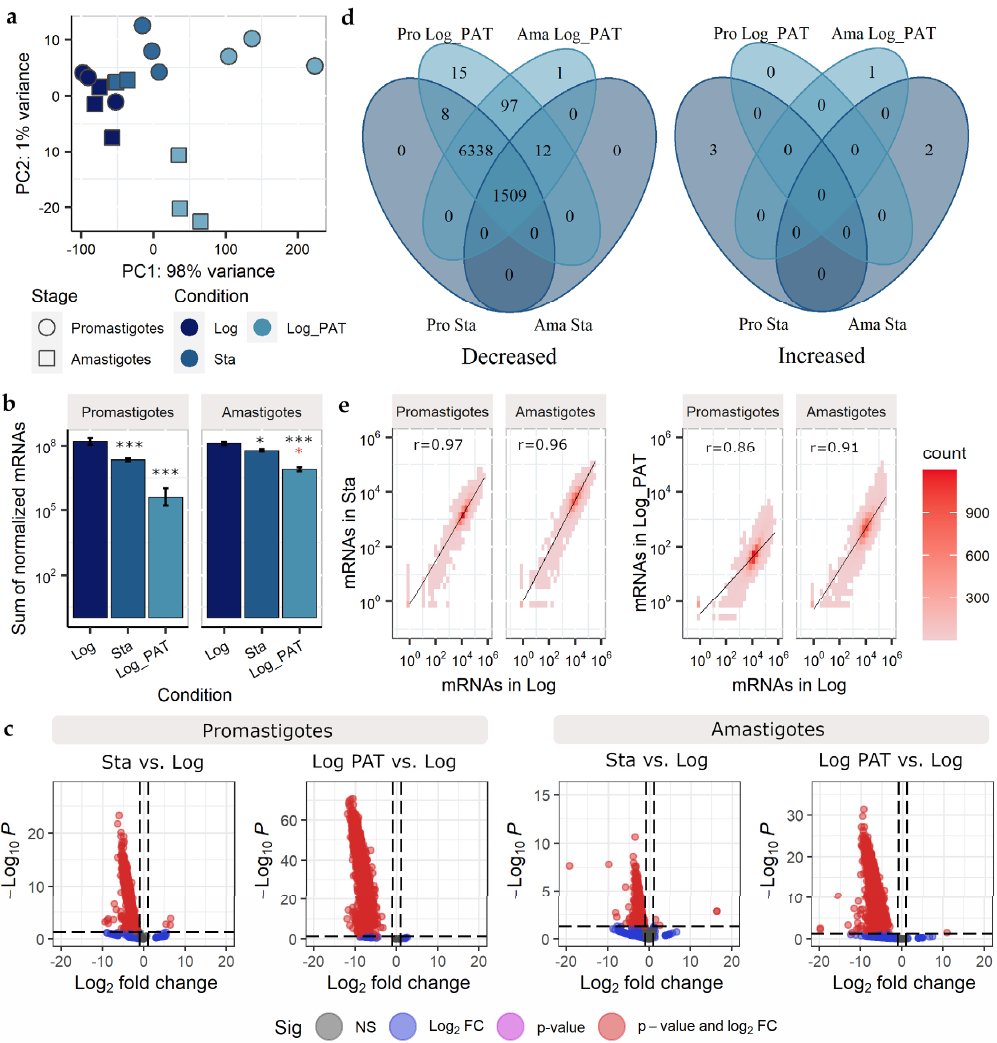
Figure 2. mRNA transcriptome size and global down-shift during quiescence. ( a ) Principal compo- nent analysis showing that most of the variability in the abundance of the mRNAs can be explained by the proliferative condition of Leishmania with quiescent cells induced by PAT drug pressure being the most dissimilar compared to proliferative cells in both promastigotes and amastigotes. ( b ) Sum of normalized mRNAs in each condition and stage of Leishmania showing the diminished transcriptome size in quiescent cells compared to proliferative cells. The bars represent the mean ± SE of three biological replicates. The asterisks in black color represent statistically significant differences after Tukey’s post-hoc test; * indicates p < 0.05, indicates *** p < 0.01. Black and red colors represent statistically significant differences in quiescent cells compared with promastigotes and amastigotes in Log, respectively. ( c ) Volcano plots showing the magnitude of change in the relative abundance of each mRNA in quiescent cells compared with proliferative cells. The plots show the global down-shift of the transcriptome in quiescent cells induced by both PAT or the stationary phase in both Leishmania stages as most of the mRNAs have substantially decreased levels and are located in the plots. On each plot, the difference is represented by the Log2 fold change between two conditions, and its significance is represented by the negative logarithm of the p value. The two vertical lines in each plot represent the Log2 fold change cutoff of 1 and − 1 for increased or decreased levels, respectively. The horizontal line represents a 0.05 cutoff for the p value. ( d ), Venn diagram representing the number of mRNAs with decreased or increased abundance in quiescent cells compared with proliferative cells. ( e ), Pearson correlation between the abundance of mRNAs in quiescent conditions compared with proliferating cells. The color indicates the number of mRNAs within a particular